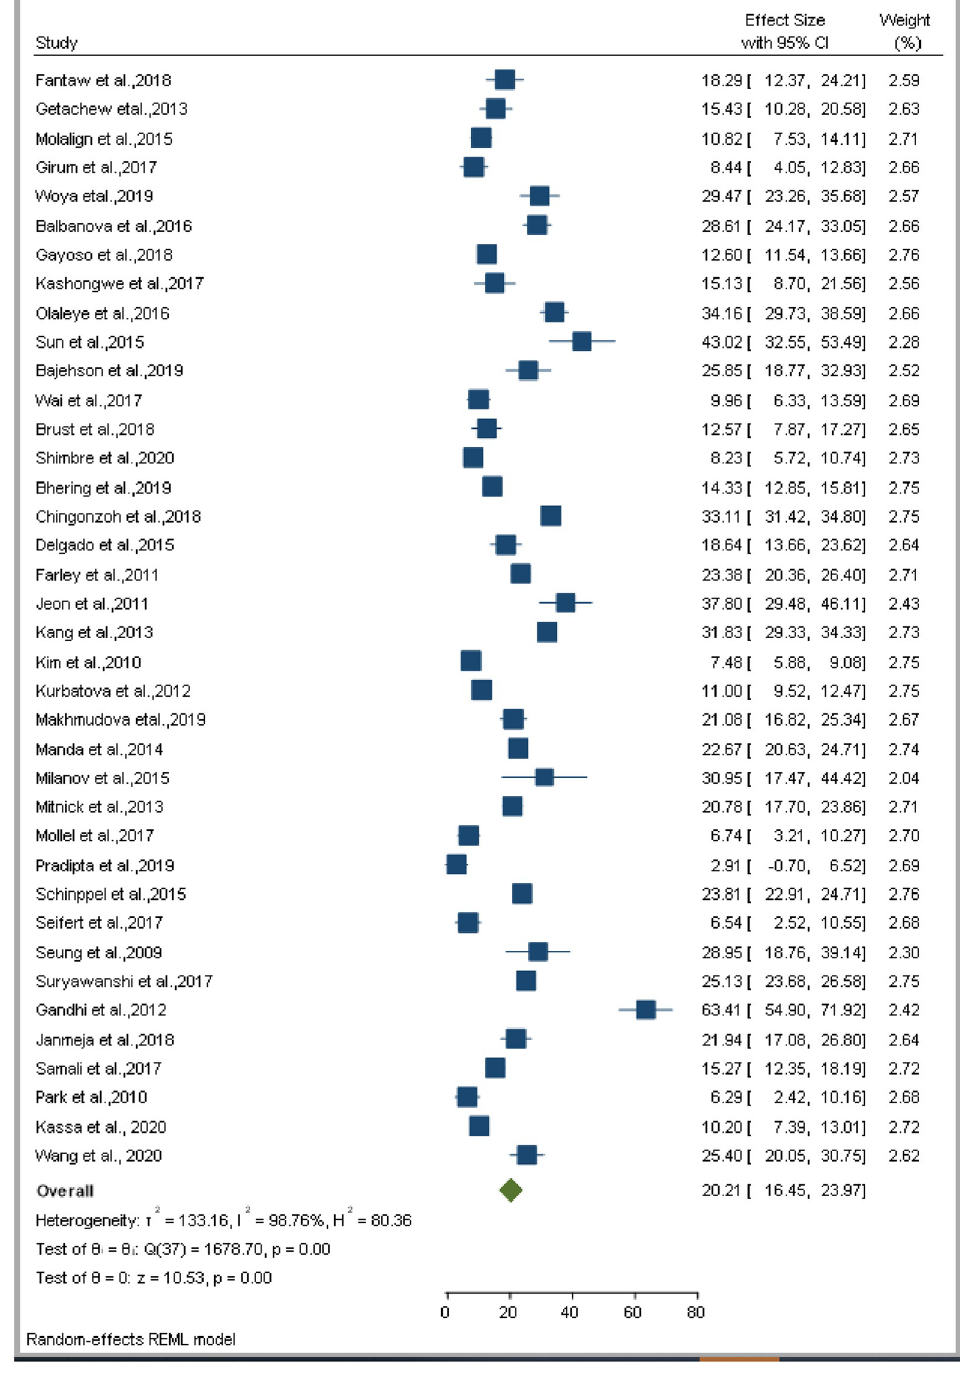
PLOS ONE | https://doi.org/10.1371/journal.pone.0253848 June 28,